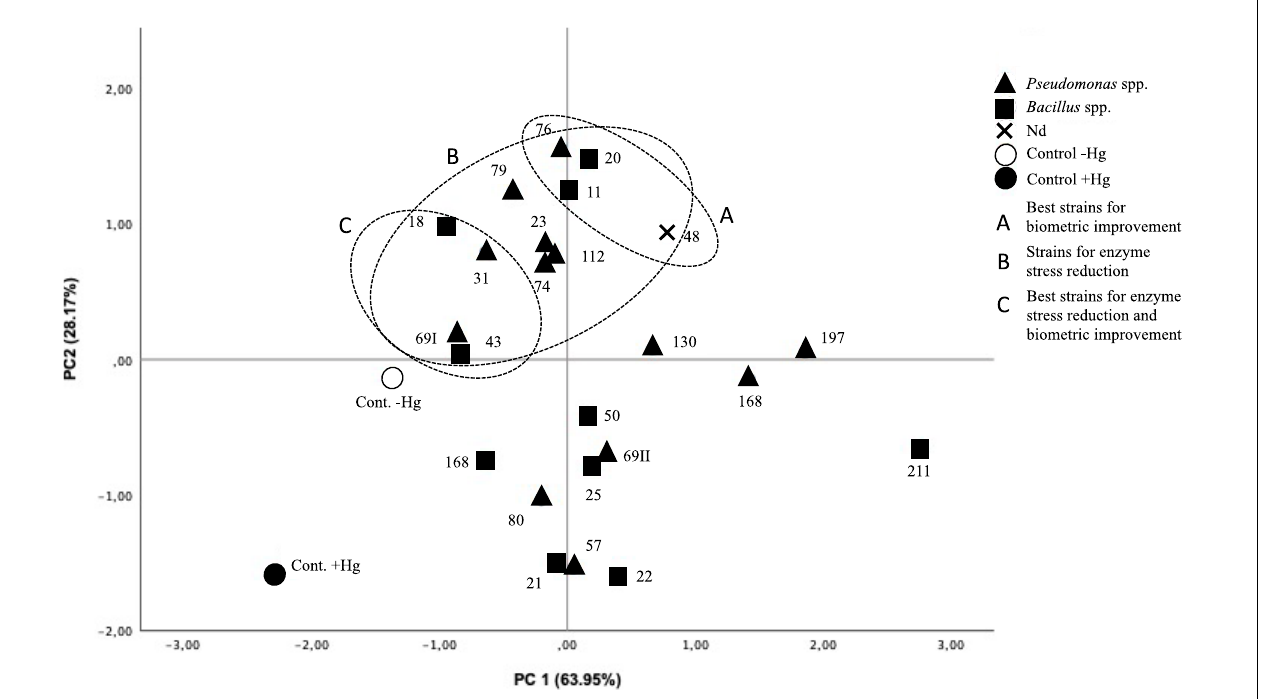
FIGURE 2 | Projection of the two main components (PC1 63.95% and PC2 28.17%). Treatments with higher elongations and root weights segregate toward the quadrant ( x , y ). Treatments with a high antioxidant response, which distances them from control in the absence of Hg, segregate toward the ( x , – y ) quadrant. Treatments close to control without Hg are grouped in the (– x , – y )